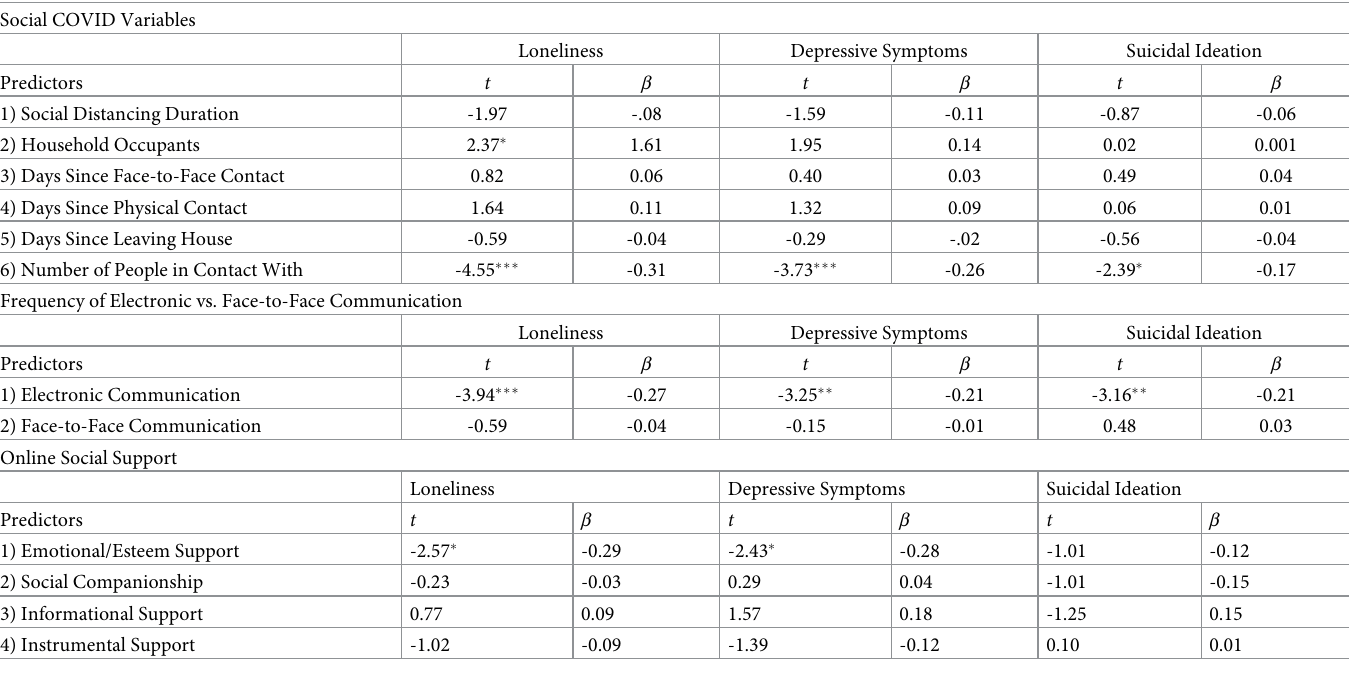
Table 4. Multiple regression